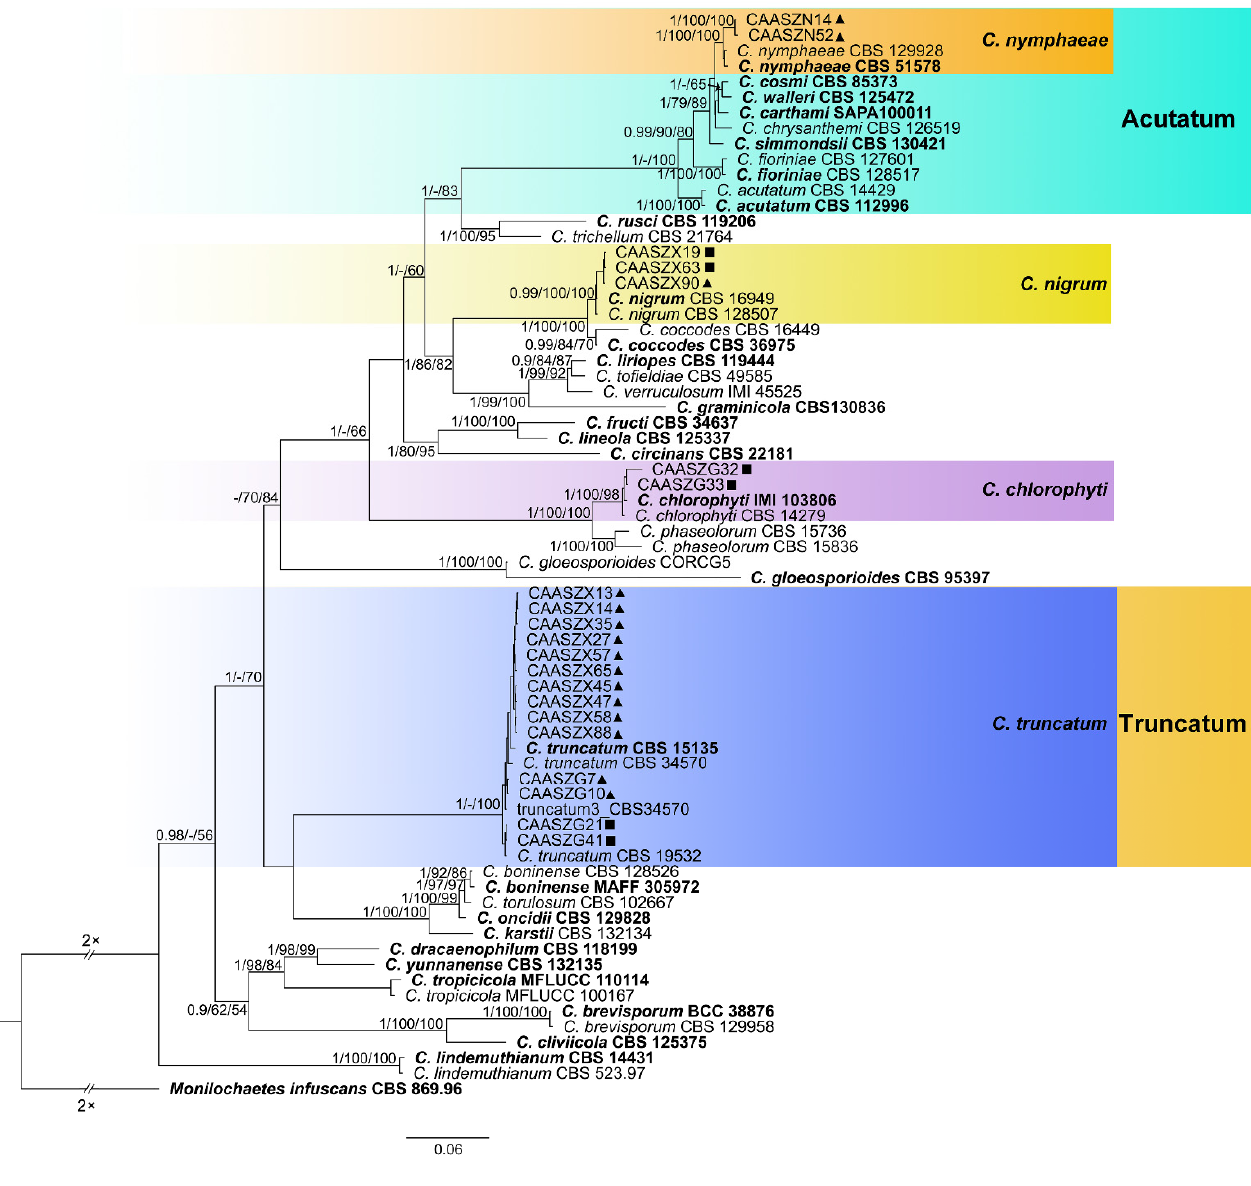
Figure 7. Phylogenetic tree generated by Bayesian inference based on concatenated sequences of the ITS, gadph , chs-1 , his3 , act and tub2 genes. Monilochaetes infuscans (CBS 869.96) was selected as an outgroup. Bayesian posterior probability (PP ≥ 0.90), MP bootstrap support values (MP ≥ 60%), and iqtree bootstrap support values (ML ≥ 50%) were shown at the nodes (PP/MP/ML). Ex-type isolates are in bold. Colored blocks indicate clades containing isolates from Citrullus lanatus in this study; triangles indicate strains isolated from leaves, rectangle indicate strains isolated from stems. The scale bar indicates 0.06 expected changes per site.